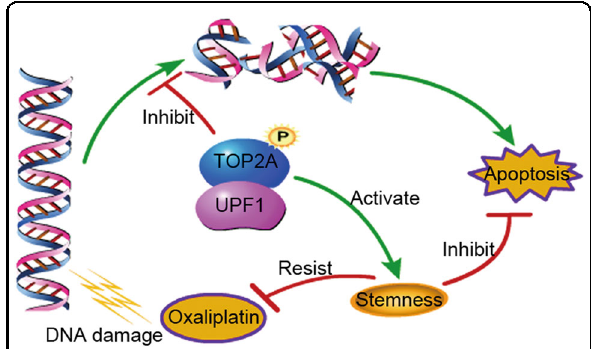
Fig. 8 Schematic diagram of this study. UPF1 protects CRC cells from oxaliplatin-induced apoptosis via regulation of TOP2A activity and maintenance of